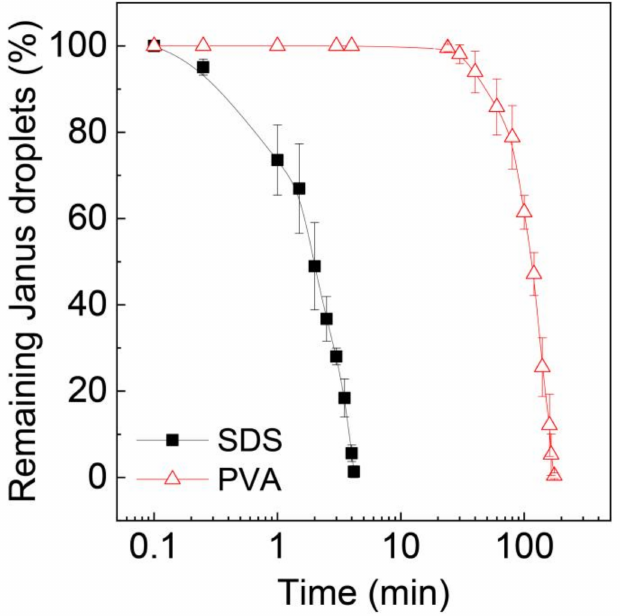
Figure 6. Decrease in Janus droplets by coalescence over time. Surfactant concentration in the silicone oil phase of the Janus droplets in aqueous PVA solution is 0.1 wt.%. Droplets were produced at Q m = Q s = 0.3 mL h − 1 , and Q c = 8.0 mL h − 1 . The error bars indicate standard deviation of the measurements ( n =